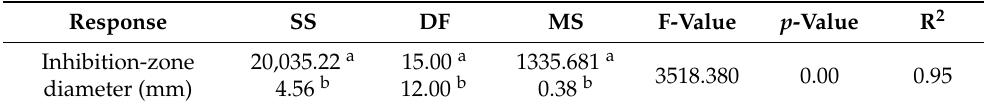
Table 9. ANOVA for the inhibition-zone diameter in the phase of RSM modeling of medium compo- sition using A. flavus PA2DSS as test microorganism.